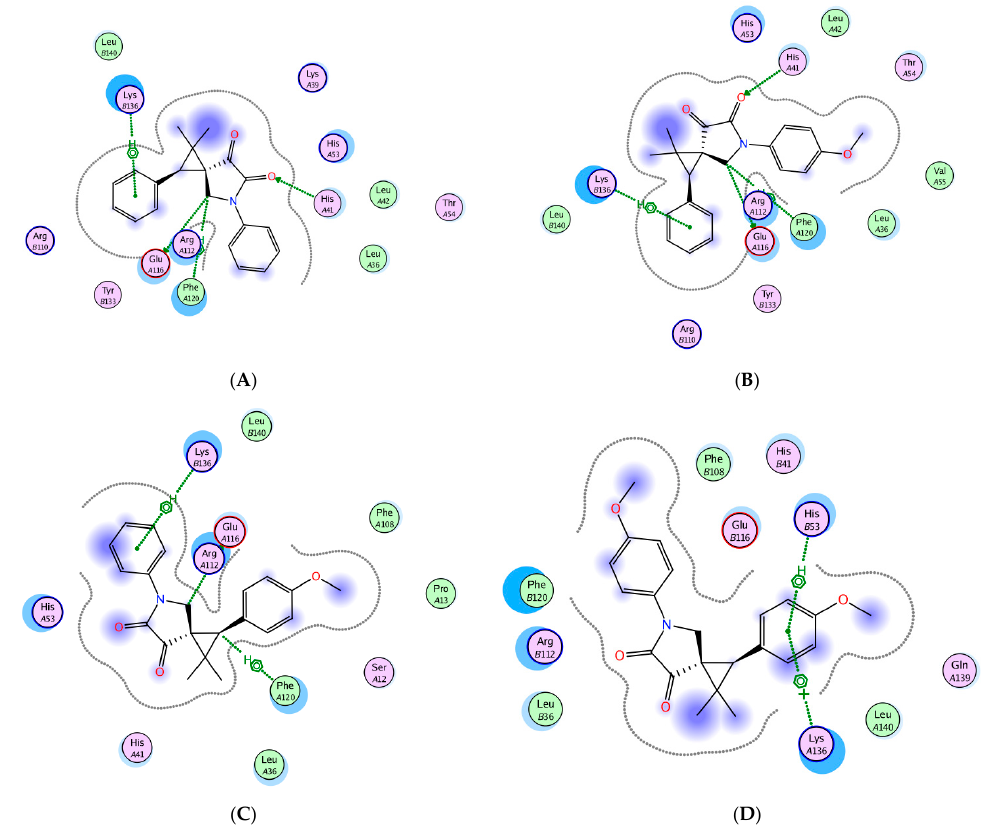
Figure 4. Two-dimensional interaction images of docking conformations of the cyclopropanes 5a-d with the active protein 5FT3. ( A ) Interaction cyclopropane 5a and protein 5FT3, ( B ) Interactions cyclopropane 5b and protein 5FT3, ( C ) Interaction cyclopropane 5c and protein 5FT3, ( D ) Interaction cyclopropane 5d and protein 5FT3. The 3D image of the molecular docking of cyclopropane 5c against protein 5ft3 is shown in Figure 5. Cyclopropanes 5a and 5b formed three hydrogens bonds with the Glu116, Phe120 and His41 active amino acid residues and one H-arene interaction with His4. Cyclopropane 5d formed two H-arene interactions with His53 and Lys136 active amino acid residues.